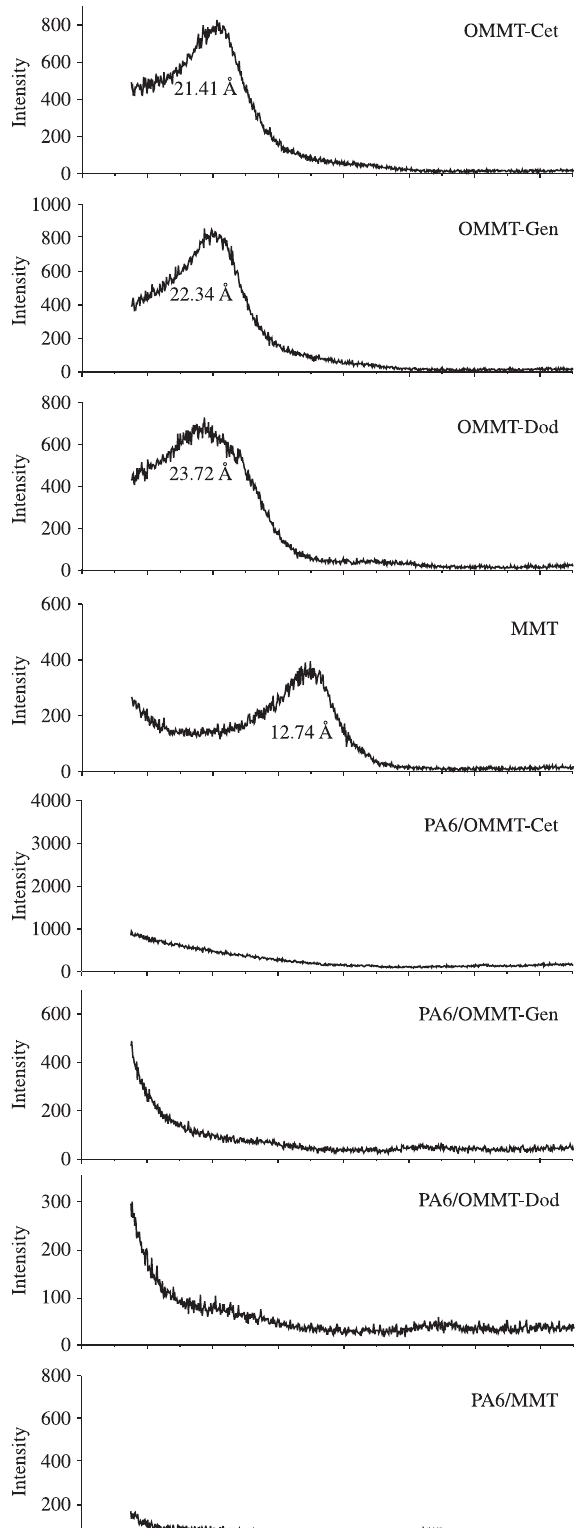
Figure 1. XRD patterns of a) unmodified clay (MMT) and modified with the salts: Dodigen (OMMT-Dod), Genamin (OMMT-Gen), Cetremide (OMMT-Cet); and b) PA6/clay